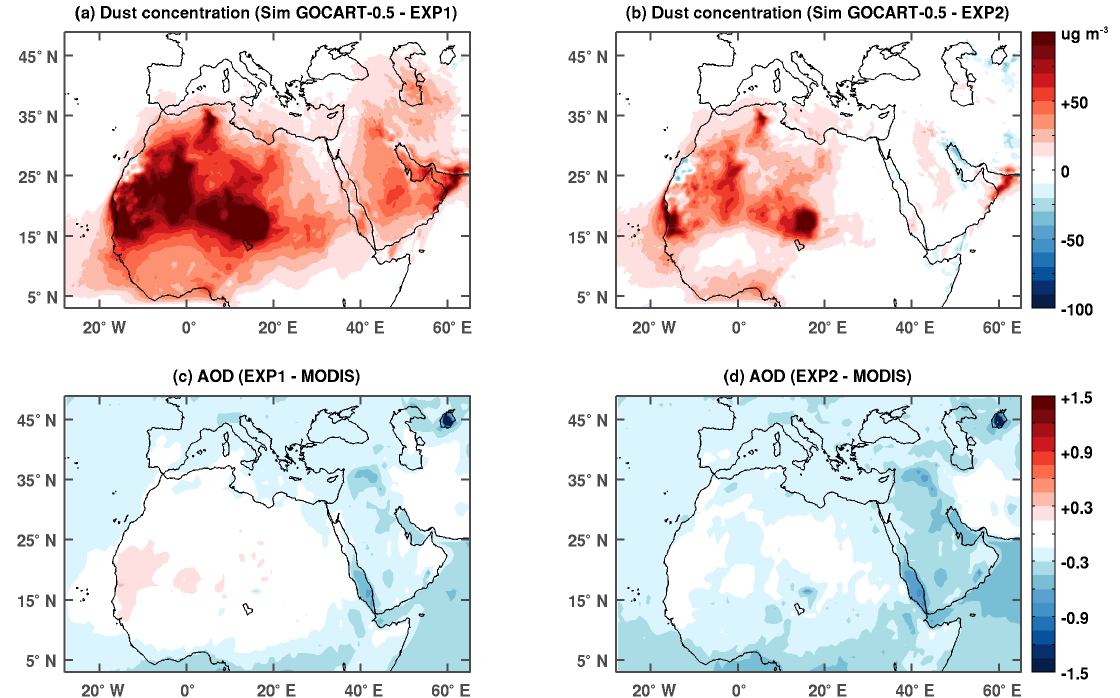
Figure 14. (a) Simulated near-ground dust concentration differences between EXP1 and Sim_GOCART-0.5, averaged over the 6-month period. (b) As in panel (a) but for EXP2. (c) AOD differences between EXP1 and MODIS observations, averaged over the 6-month period. (d) As in panel (c) but for